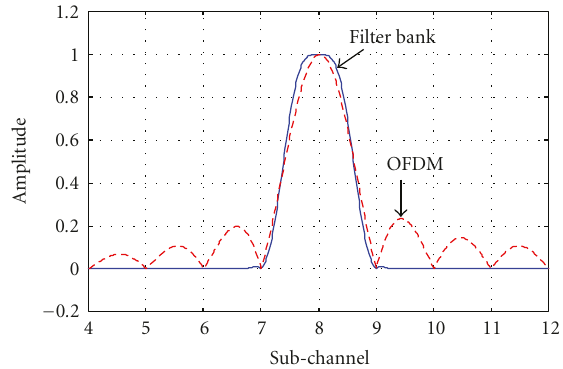
Figure 4: Single subcarrier PSDs of the OFDM and FBMC